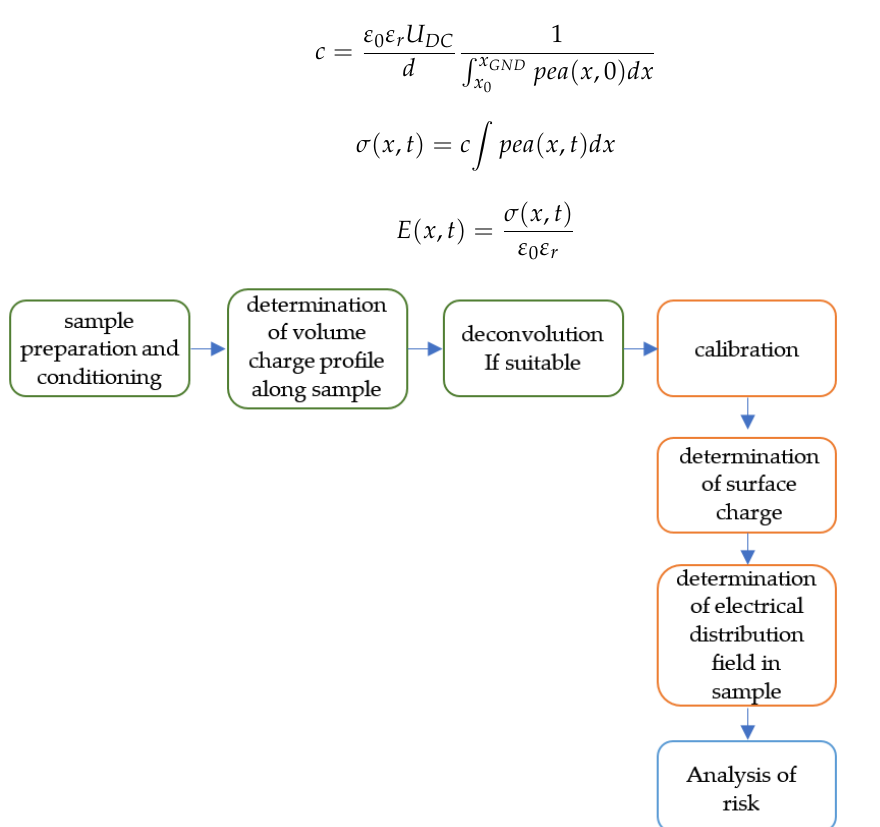
Figure 1. Algorithm for the determination of electrical field distribution based on the measurement of space charge profile in the flat dielectric